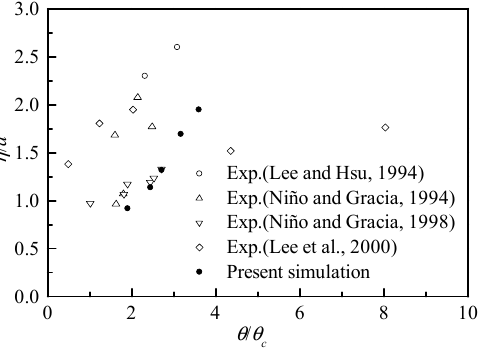
Figure 12. Dimensionless saltation height with transport stage [8,9,12,18]. The sediment particles under the action of turbulent flow collide with the bed, and three important collision angles are used to characterize the saltation process, i.e., incidence angle θ in , takeoff angle θ out , and collision position angle θ b as shown in Figure 13. The angles of incidence θ in and takeoff θ out are defined with respect to a line parallel to the channel bottom, and they are calculated through the particle trajectory right before and after the collision [33]. The collision position angle θ b is the angle between the tangential collision surface and the bed bottom. Based on the magnitude of the collision position angle, the collision point is located on the upstream ( θ b > 0) and downstream faces ( θ b < 0) of the bed particle. In this study, the analysis on the incidence angle θ in and takeoff angle θ out are presented. The results on the collision position angle θ b involve the analysis of the “splash function”, which will be studied in future research